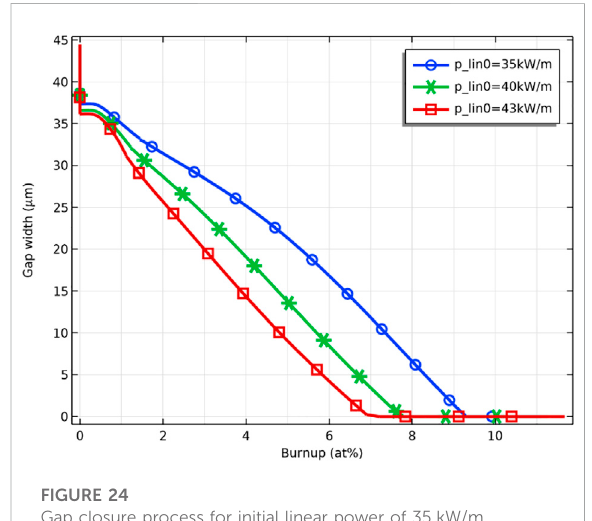
FIGURE 25 Fission gas release fraction at initial linear power of 35 kW/m, 40 kW/m and 43